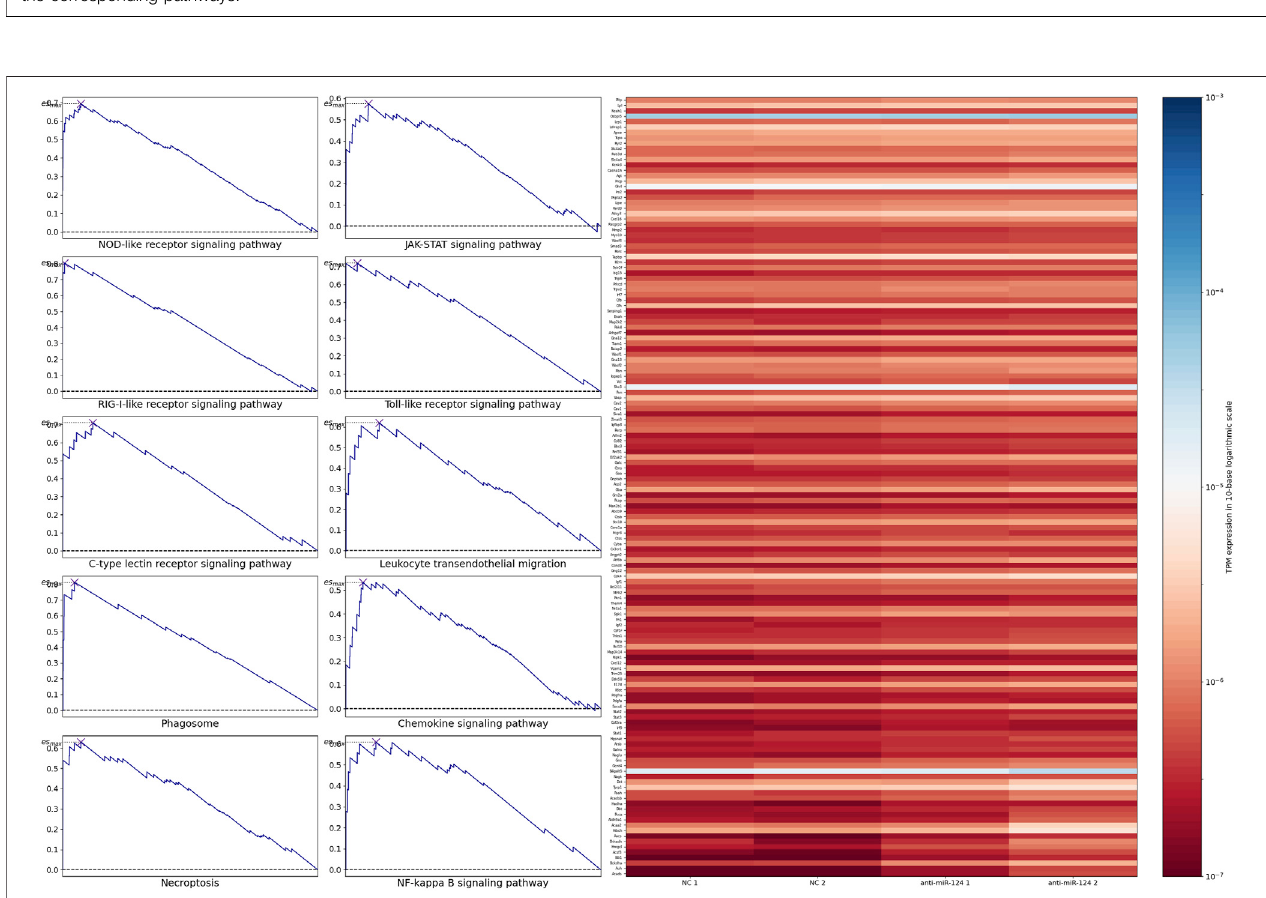
FIGURE 3 | The left panel indicated the top 10 enriched pathways. The right panel indicated the expression level of the union of their leading-edge subsets.